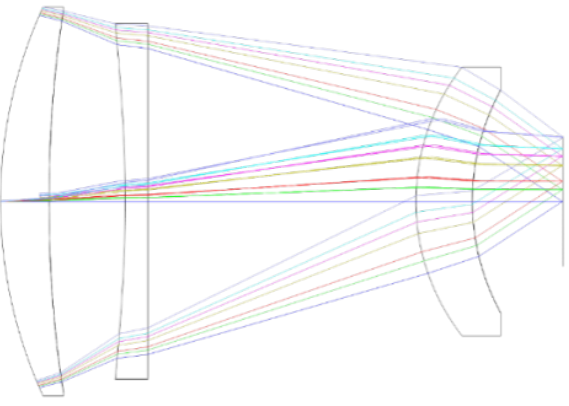
Figure 1. Optical path diagram of wide band infrared system.